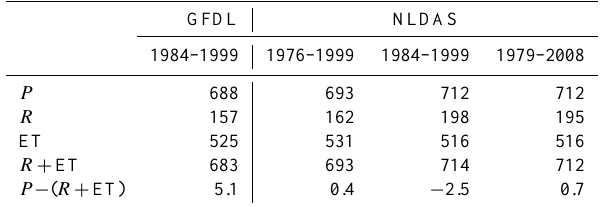
Table 6. Water balance comparison of GFDL against NLDAS ( P = precipitation; R = total runoff; ET = evapotranspiration) for the Upper Midwest region. GFDL